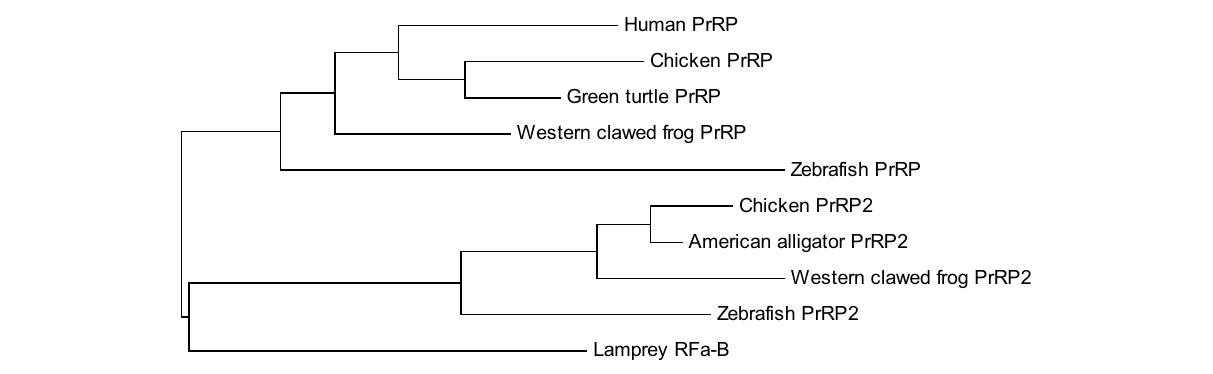
of NPY was able to bind and inhibit completely the PrRP-induced response in cells, which express PrRP-R, suggesting that PrRP-R shares a common ancestor with NPY receptors (13). On the other hand, it is likely that PrRP binds to not only the PrRP receptor but also other receptors such as neuropeptide FF receptor-2